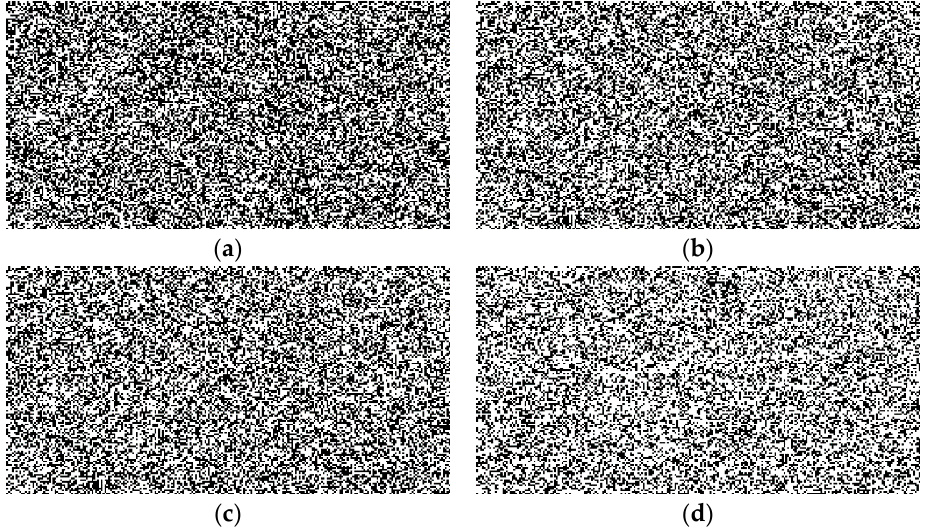
Figure 18. Resized Black& White Data Image ( a ) Image 1, ( b ) Image2, ( c ) Image 3, and ( d ) Image 4.